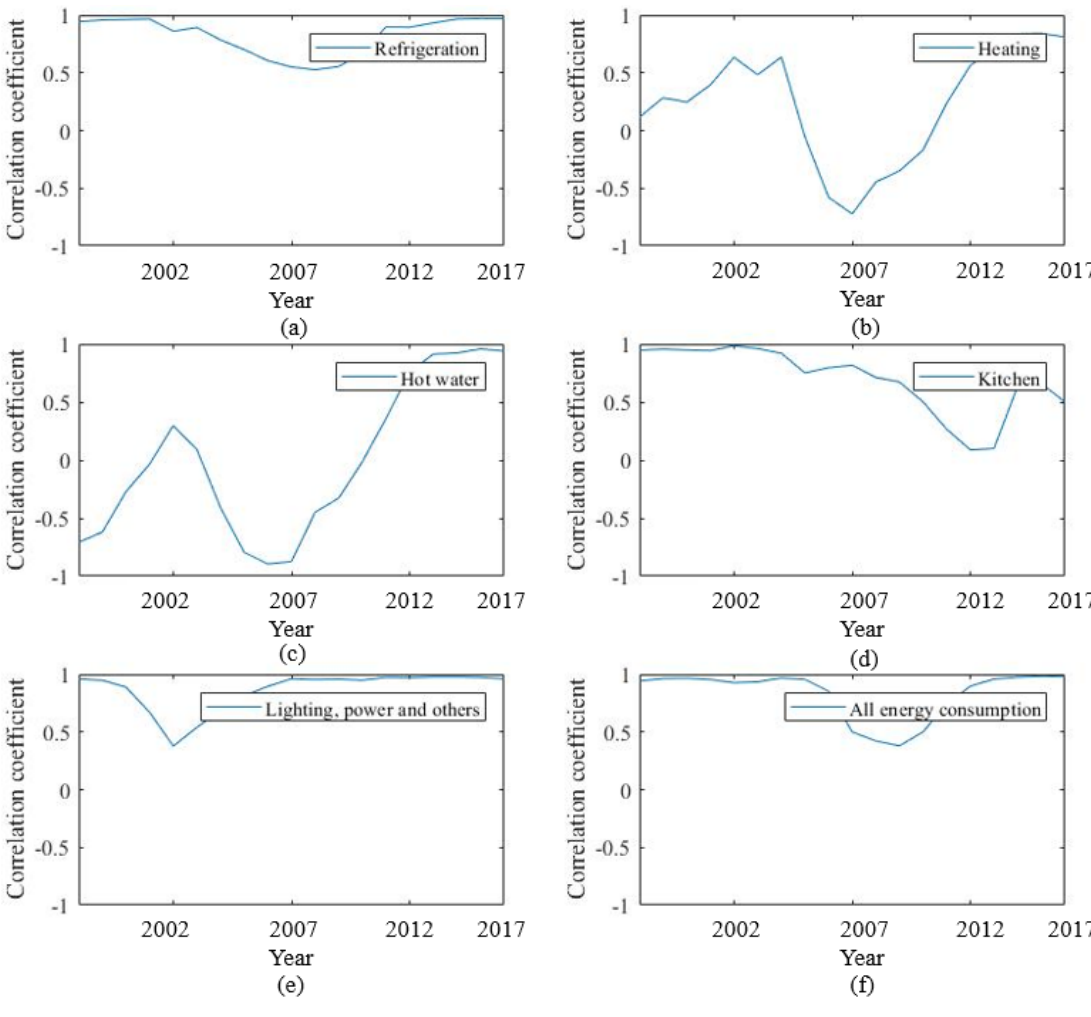
Figure 6. The policy identification results of the tertiary industry (( a ) Refrigeration; ( b ) Heating; ( c ) Hot water; ( d ) Kitchen; ( e ) Lighting, power and others; ( f ) All energy consumption).